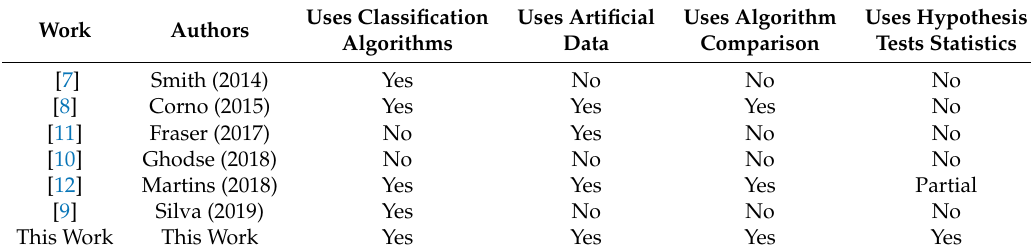
Table 1. Summary of related